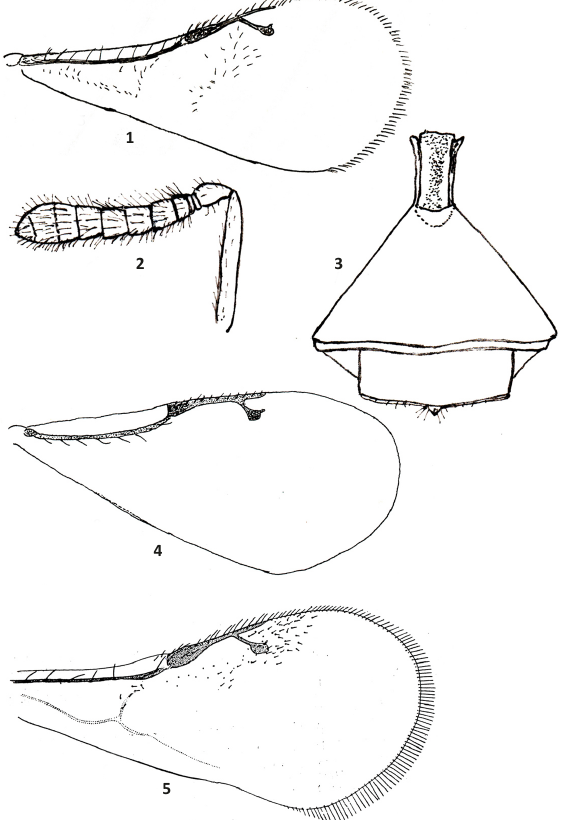
Figures 1–3. Platecrizotes keralensis sp. nov. 1 - female forewing; 2 - male antenna; 3 - male metasoma dorsal view; 4 - Platecrizotes argentinensis De Santis, female forewing, (courtesy. De Santis 1988); 5 - Platecrizotes sudanensis Ferrière, female forewing (courtesy: Bouček